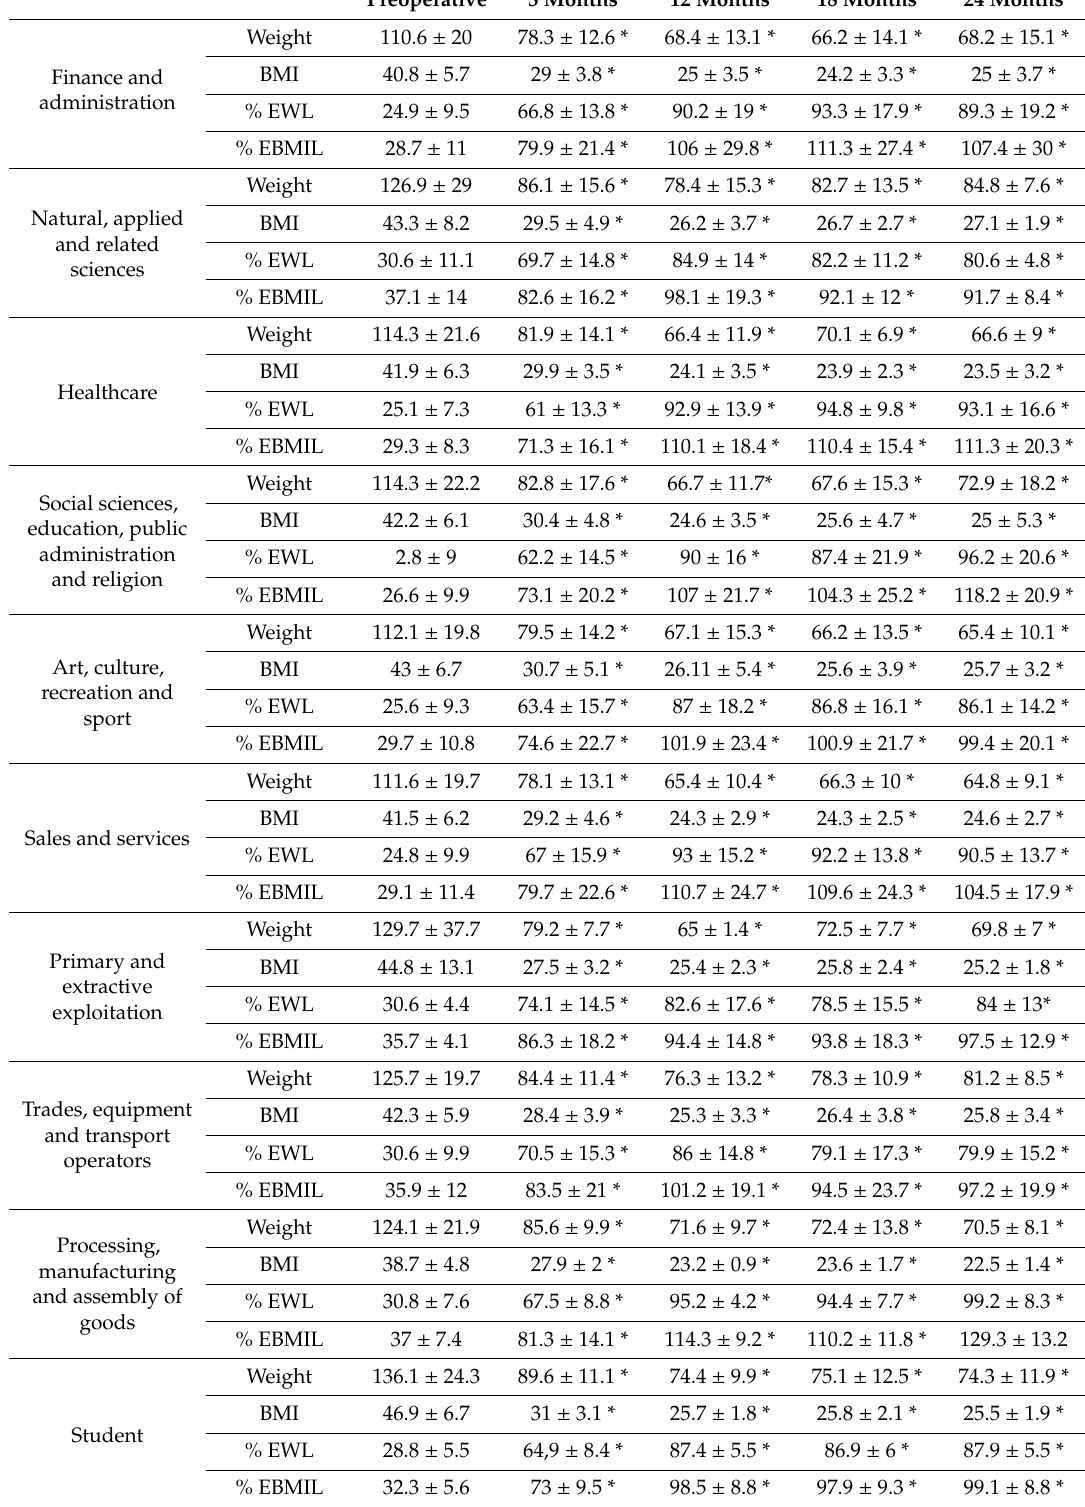
Table 2. Evolution of weight loss in the di ff erent professional fields at the time of the postoperative follow-up